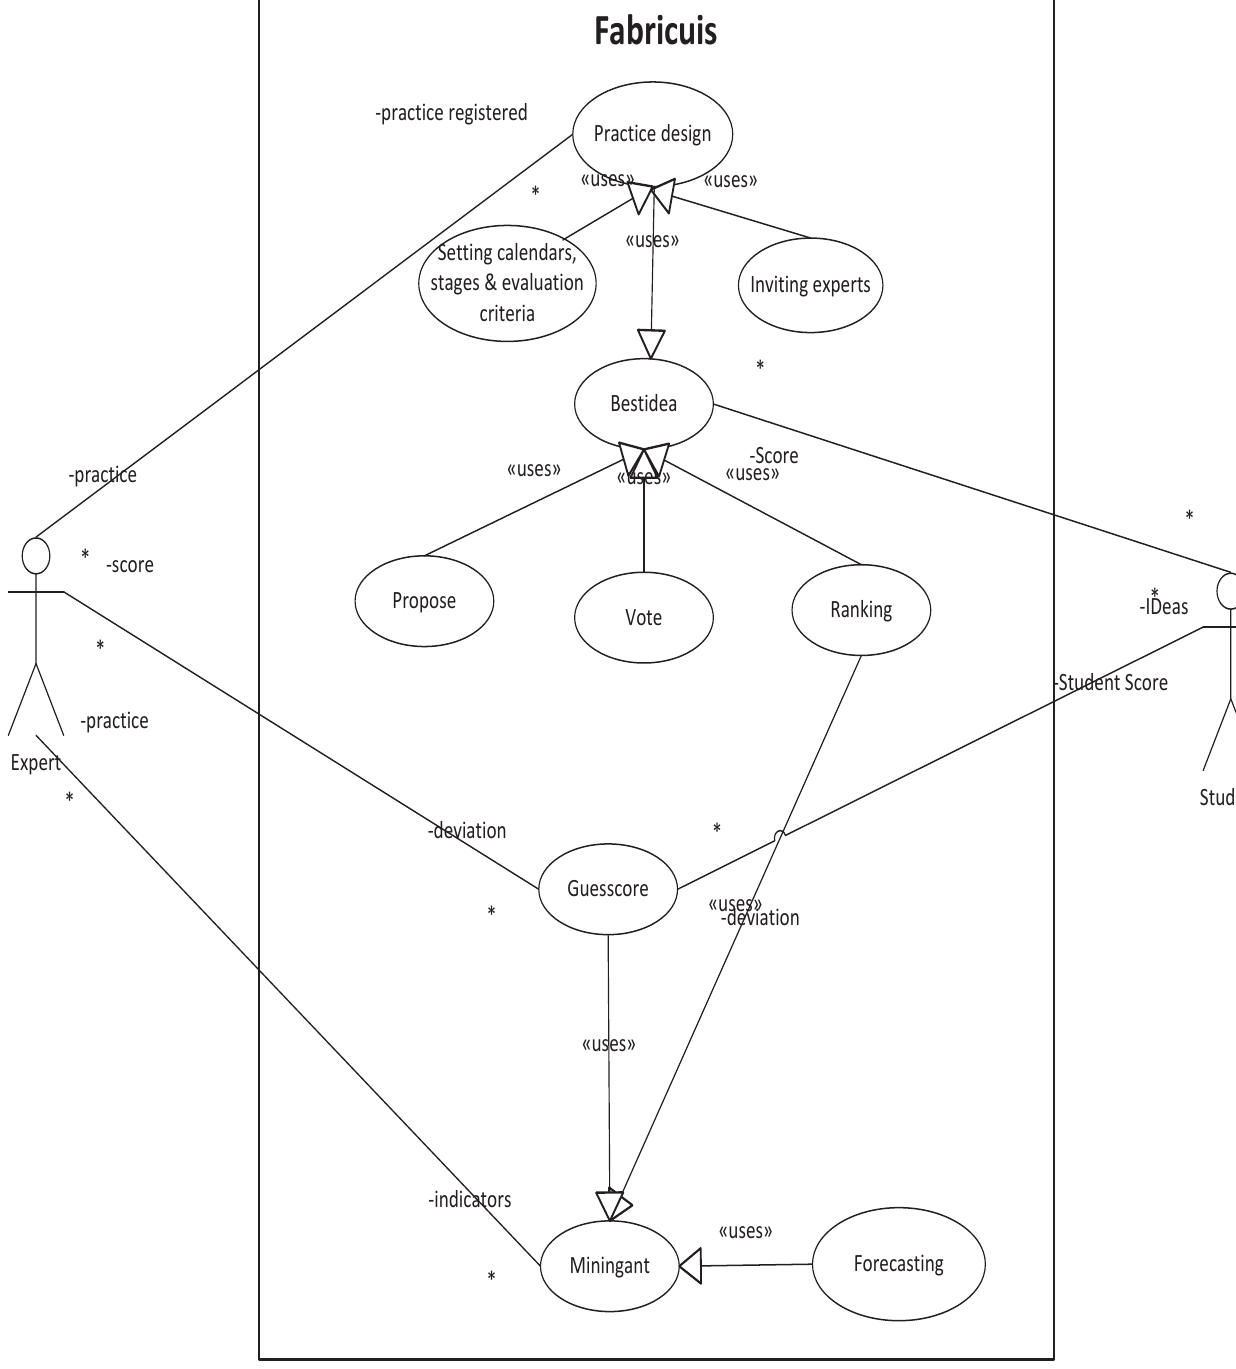
Figure 2 . Context diagram (use cases level